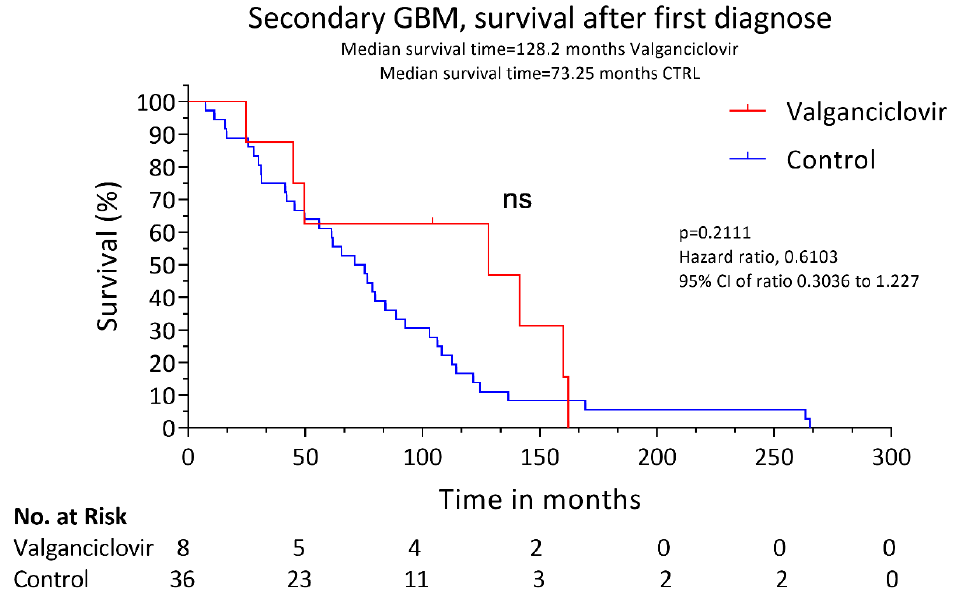
Figure 2. Kaplan–Meier estimates of overall survival after first tumor diagnosis. Estimated median OS survival after first tumor diagnosis for 8 patients with low-grade glioma that progressed later into secondary glioblastoma who received valganciclovir therapy (red) and for 36 contemporary controls who received similar therapy